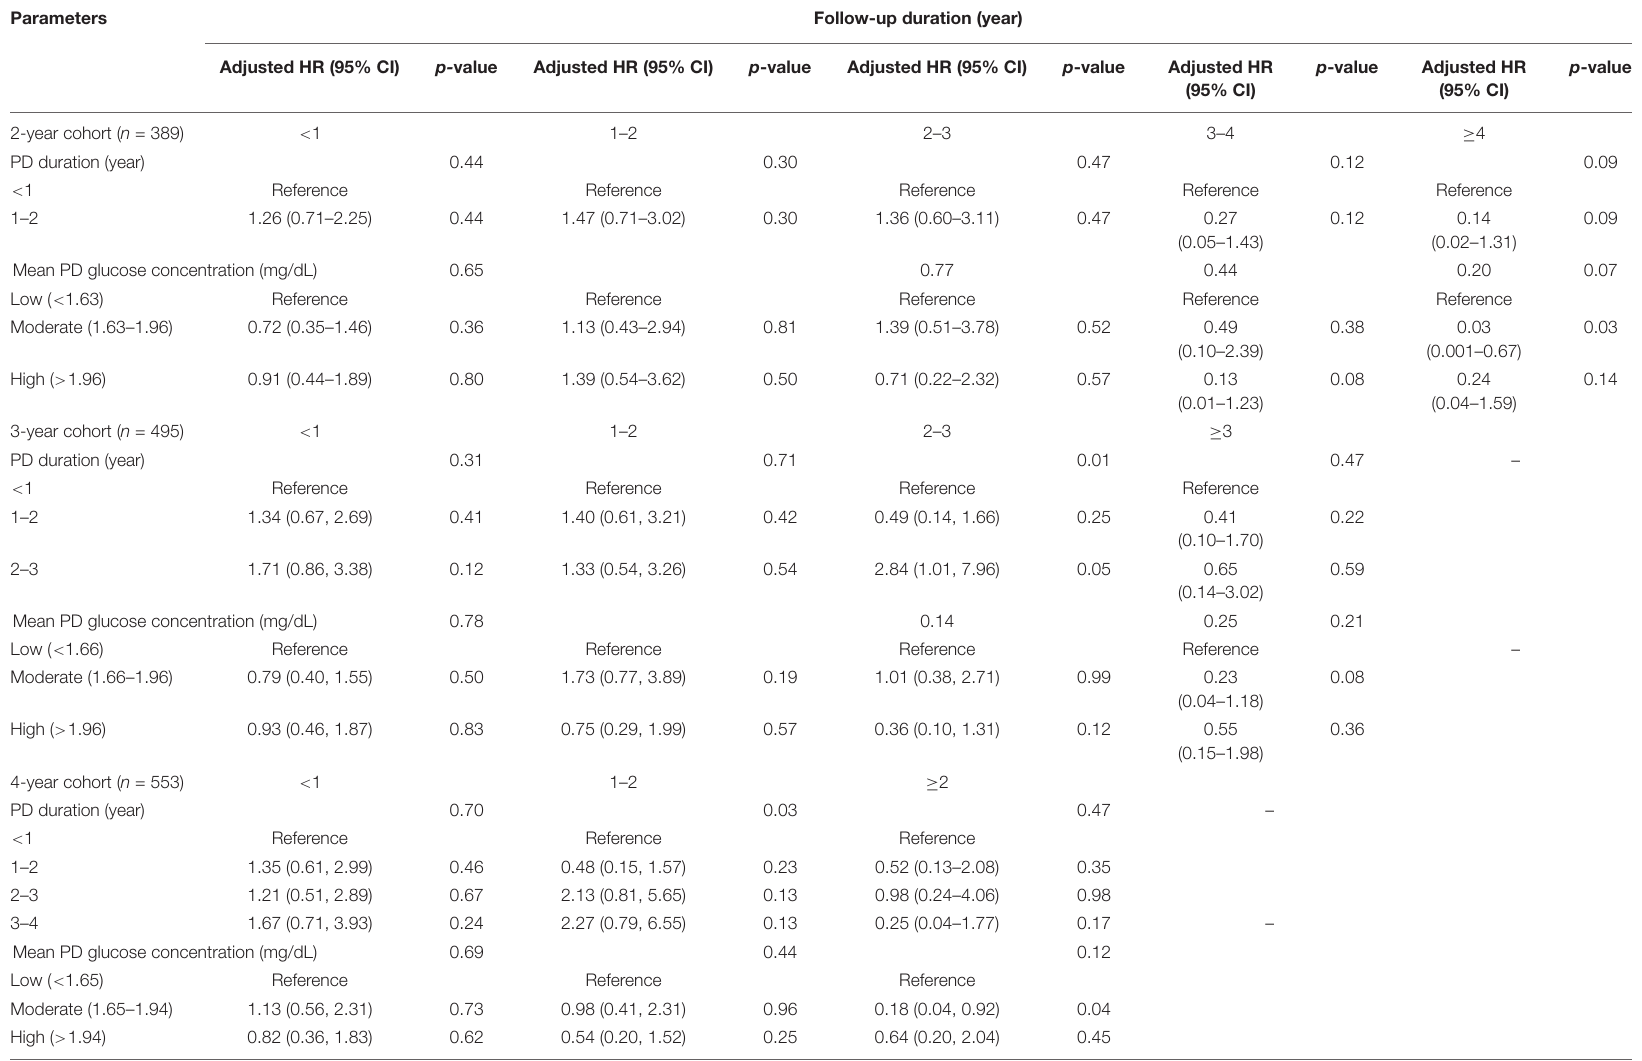
TABLE 4 | Risk of mortality concerning PD exposure by follow-up duration in three different time-window cohorts by the cause-specific Cox regression model # .